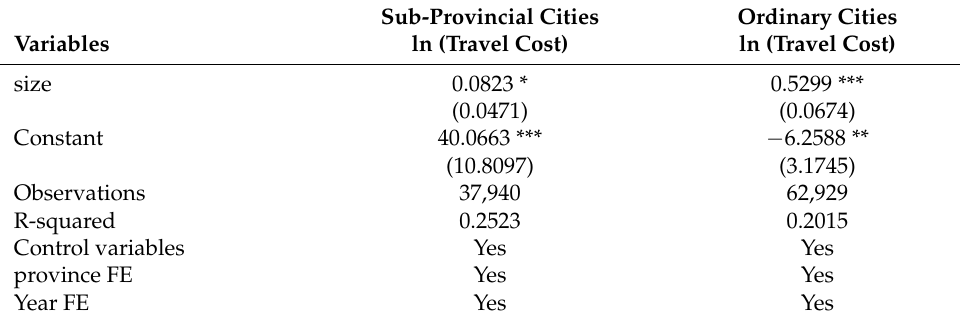
Table 7. The heterogeneous regression results.